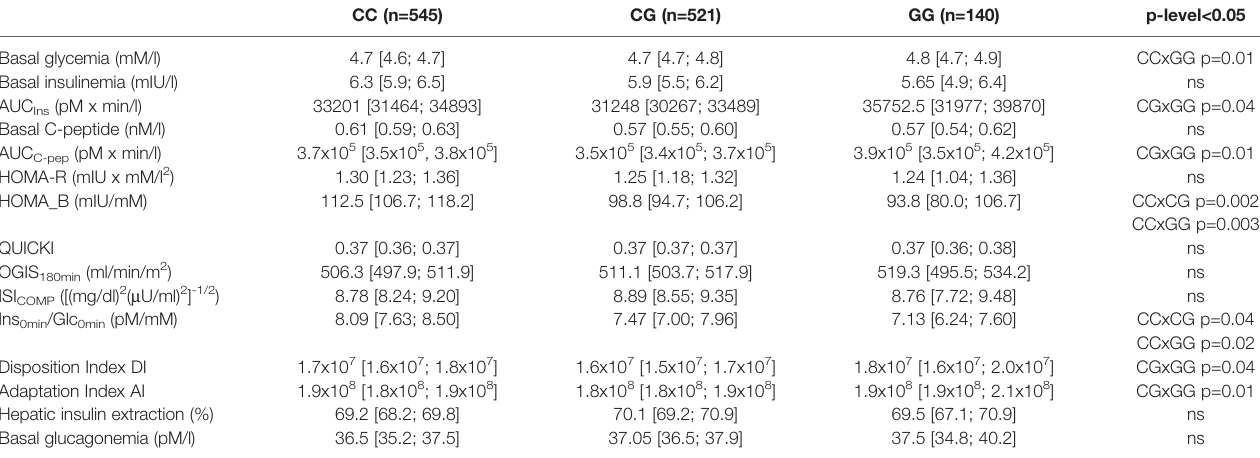
TABLE 2 | Parameters of glucose metabolism depending on the MTNR1B rs10830963